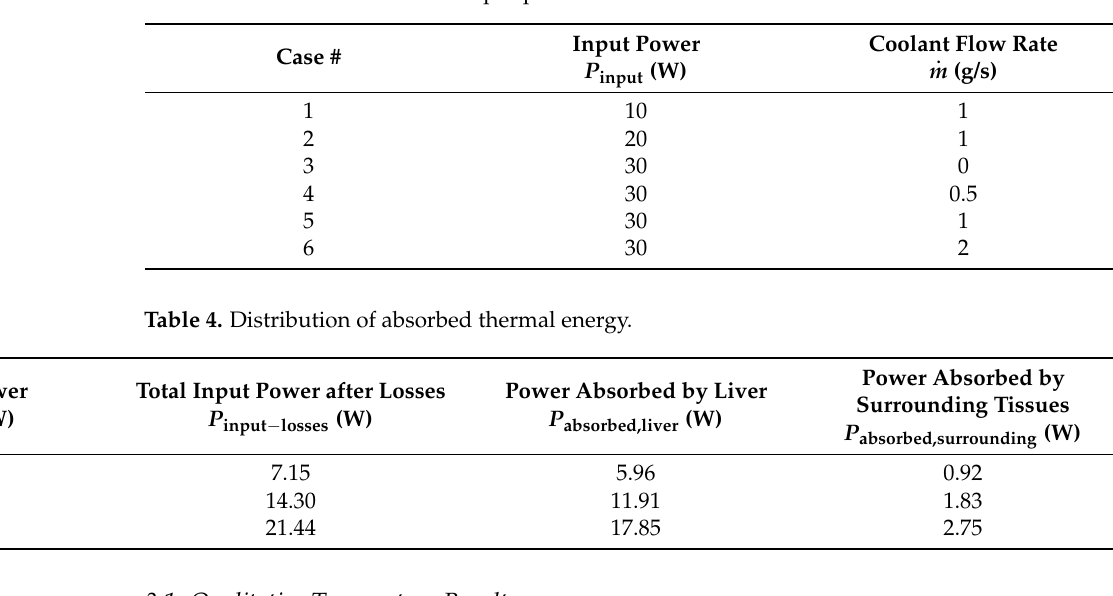
Table 3. Parametric variation of input parameters.